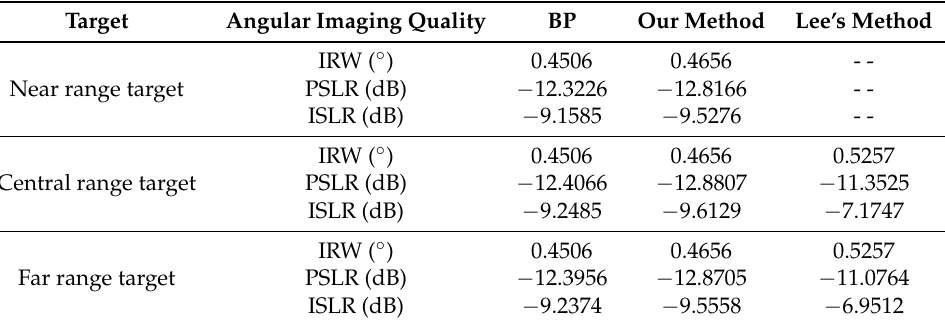
Table 2. Image quality test.